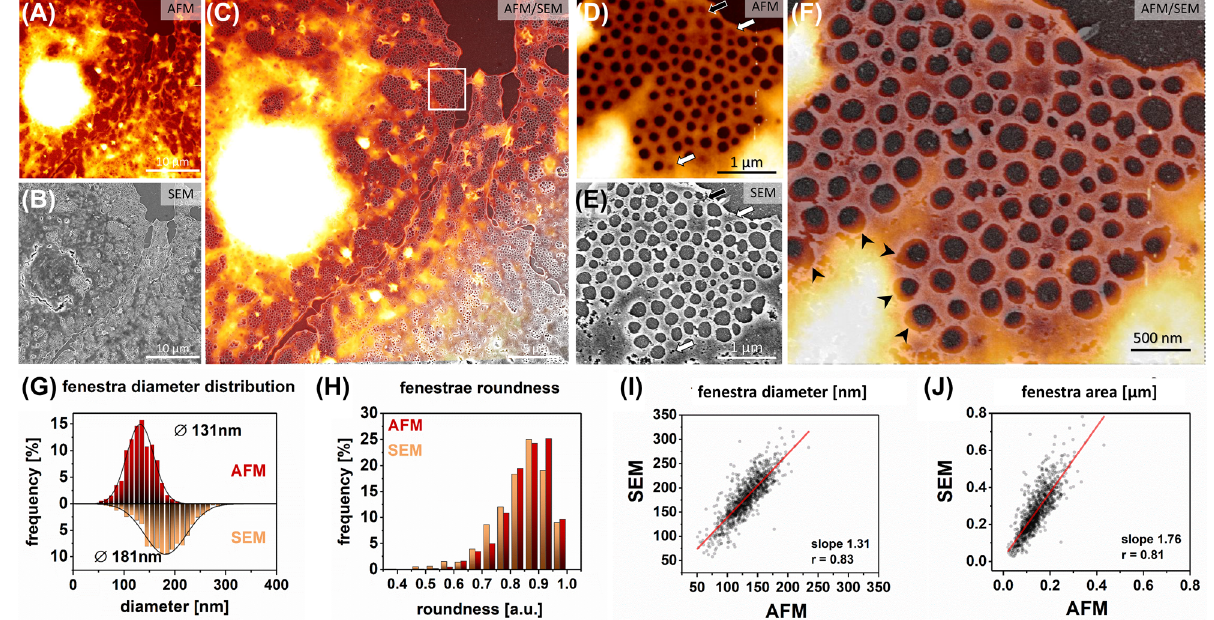
Figure 4: Correlative AFM and SEM microscopy of LSEC treated with cytochalasin B. Firstly, AFM measurements were performed for GA wet-fixed LSEC; (A) A representative AFM image of LSEC is presented. (B) The sample was dehydrated, the corresponding area was localized and measured with SEM. (C) Both AFM and SEM images were then correlated. (D – F) High- magnification image allows for precise identification of all of the fenestrations within a sieve plate. Fenestrations in the center of the sieve plate were less dilated than those on the edges (arrowheads). Some closed fenestrations identified in AFM became open (black arrow) or are not distinguishable (white arrow) in SEM. 1081 fenestrations were identified in both methods and analyzed in a one-to-one manner. (G) Histogram of fenestration diameter distribution. The black lines represent fitted Gaussian curves from which the mean diameters were calculated at the peak of the distribution (AFM 131 nm ± 31 nm, SEM 181 nm ± 48 nm). (H) Distribution of fenestration roundness measured by AFM and SEM. A comparison of individual fenestration diameter I and area J indicate uniform dilation of fenestrations in